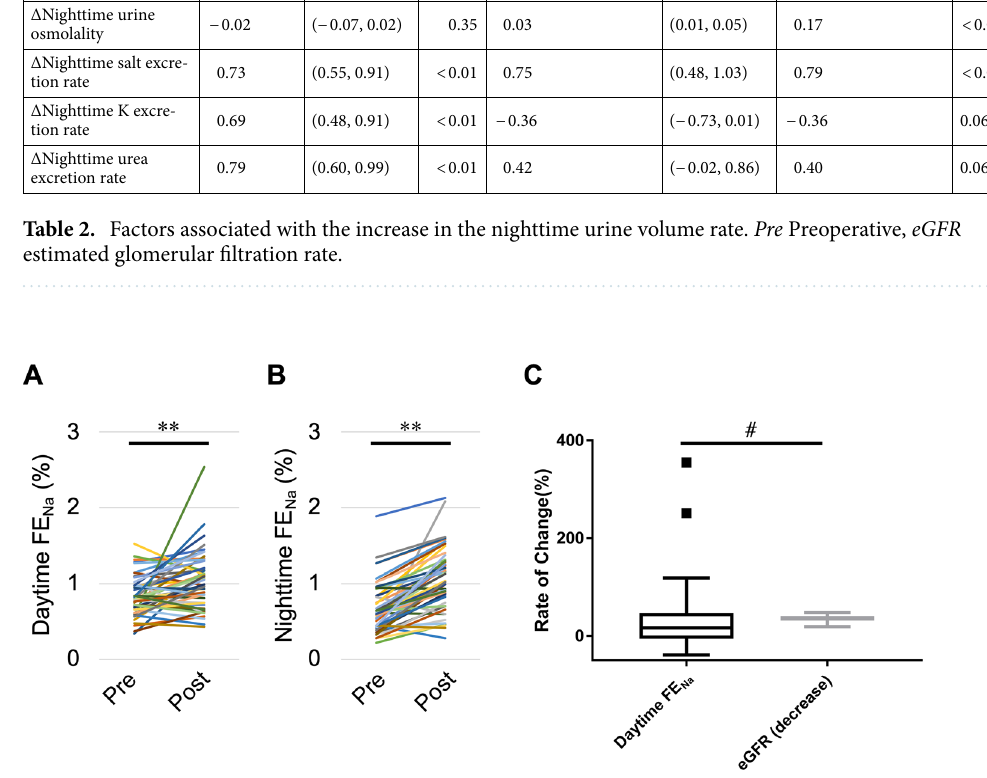
Figure 6. Changes in FE Na and the GFR caused by nephrectomy. ( A ) Daytime FE Na and ( B ) nighttime FE Na in each patient. ( C ) Tukey’s box and whisker plots for the rate of change in daytime FE Na and the eGFR (decrease). FE Na fractional excretion of sodium; eGFR estimated glomerular filtration rate, Pre preoperative, Post postoperative. ** P < 0.01, by the paired t -test; # P < 0.05, by the Wilcoxon signed rank